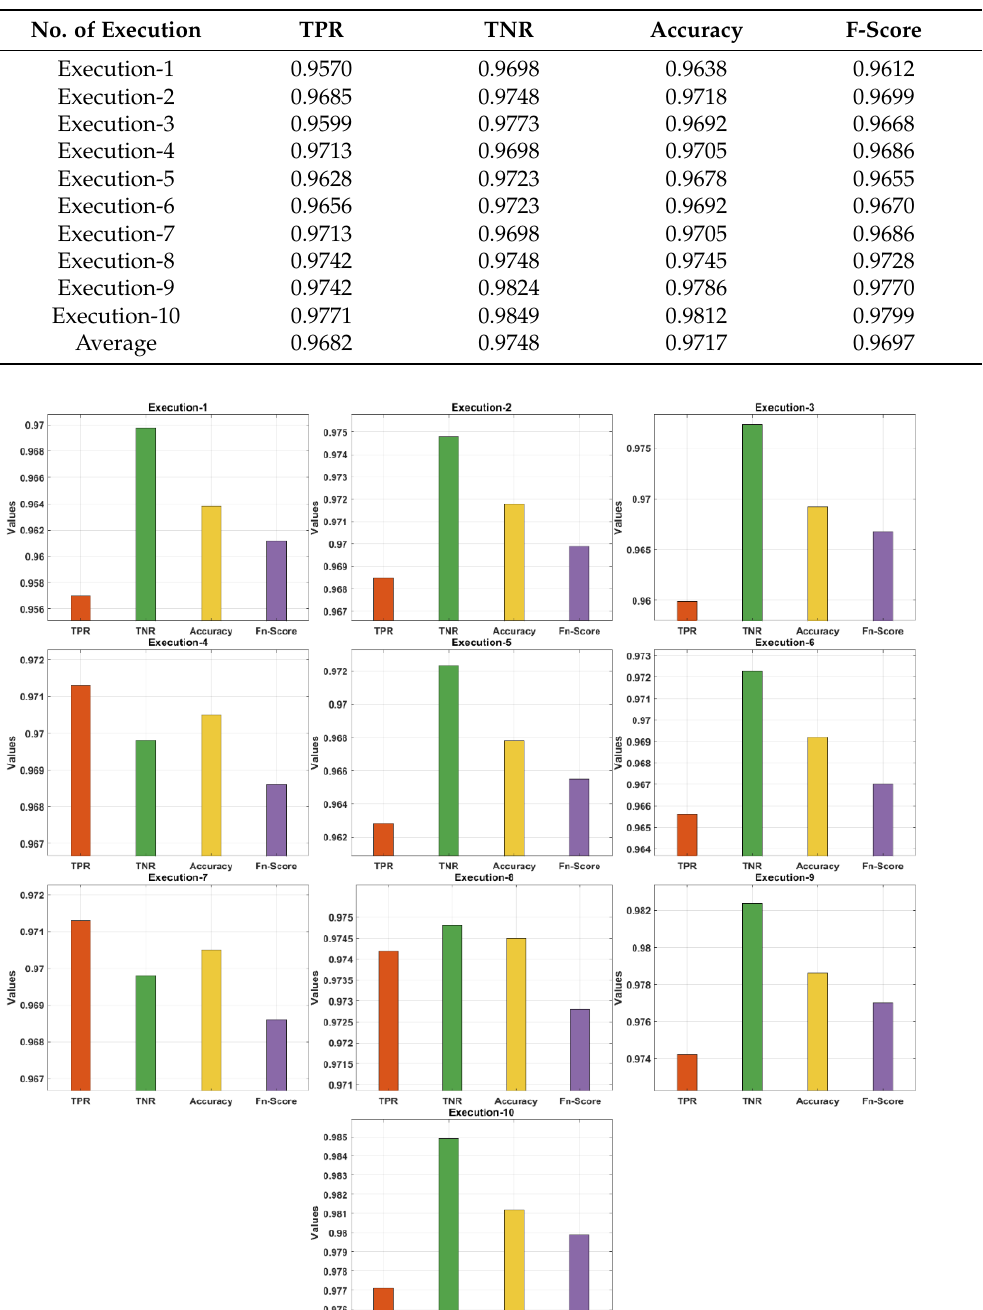
Table 1. Results analysis of proposed AIEM-DC model in terms of various measures.